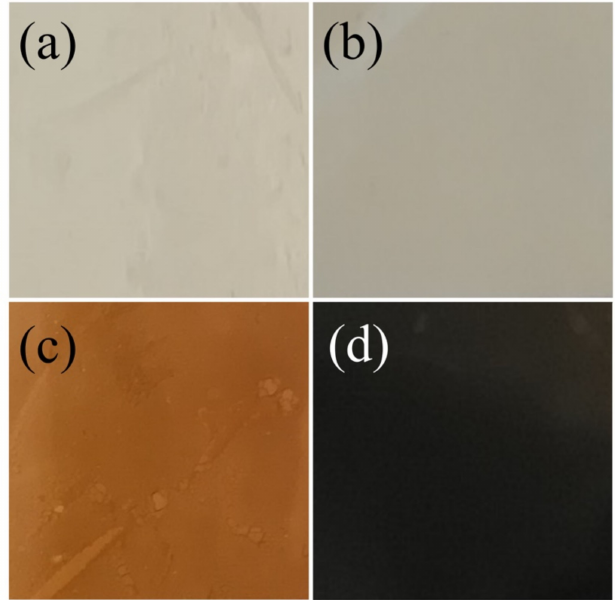
Figure 2. Photographs of: ( a ) electrosprayed spherical PVP particles, ( b ) deposition of 50 cycles of Al 2 O 3 on spherical PVP particles with ALD (PVP/Al 2 O 3 ), ( c ) deposition of 500 cycles of Fe 2 O 3 on spherical PVP/Al 2 O 3 particles with ALD (PVP/Al 2 O 3 /Fe 2 O 3 ) and ( d ) thermal reduction of PVP/Al 2 O 3 /Fe 2 O 3 particles to obtain hollow Fe 3 O 4